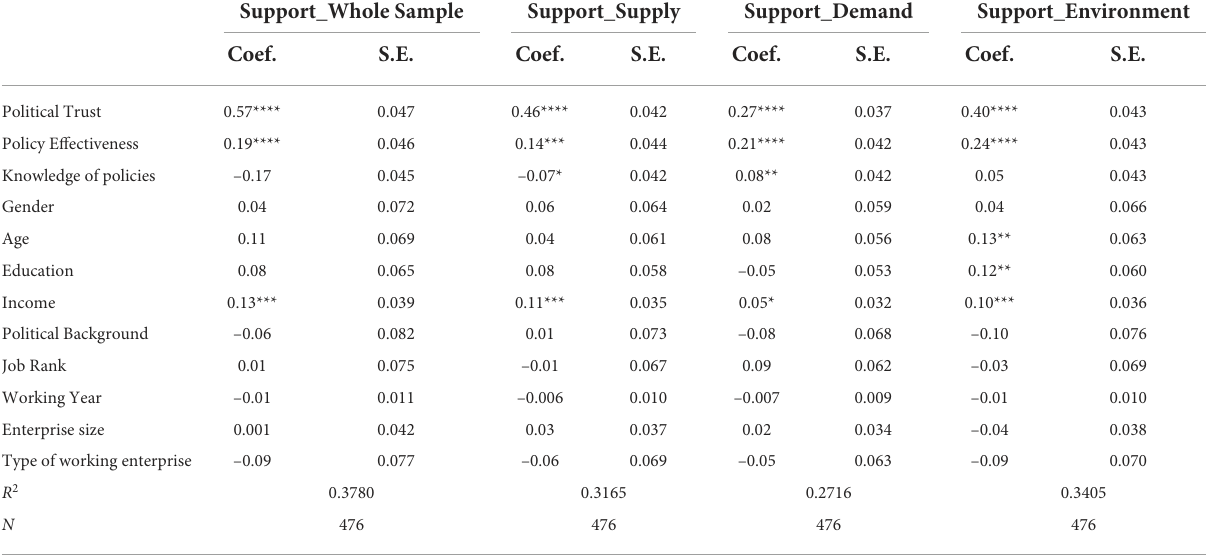
TABLE 7 Influencing factors of policy